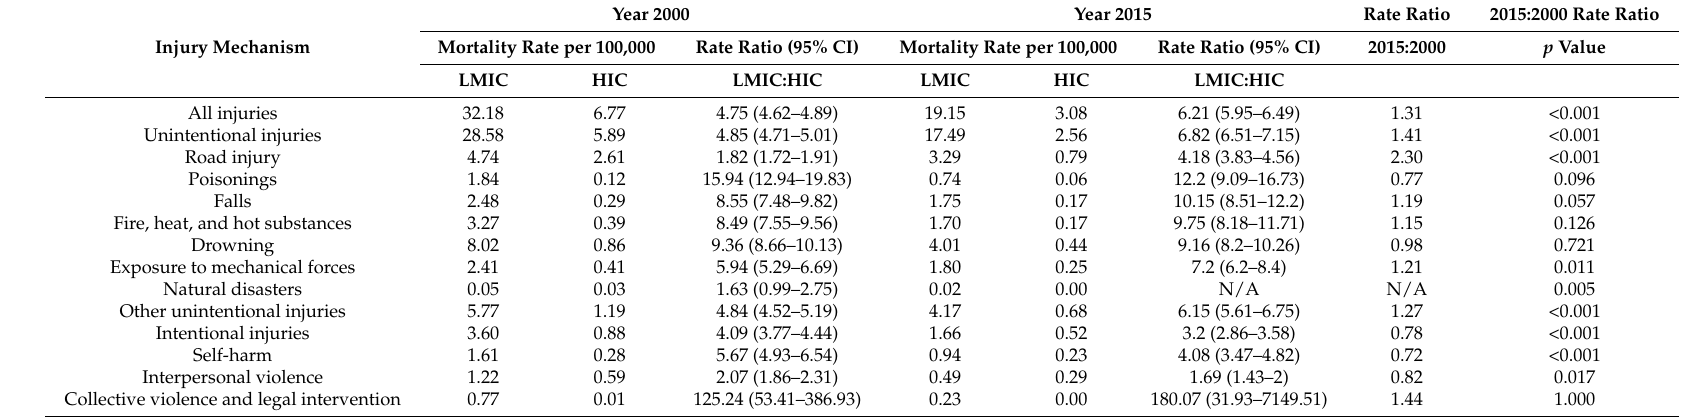
Table 2. Death rates in children aged 0–14 years in the WHO European region by injury mode in LMIC and HIC in years 2000 and 2015 and rate ratios between LMIC and